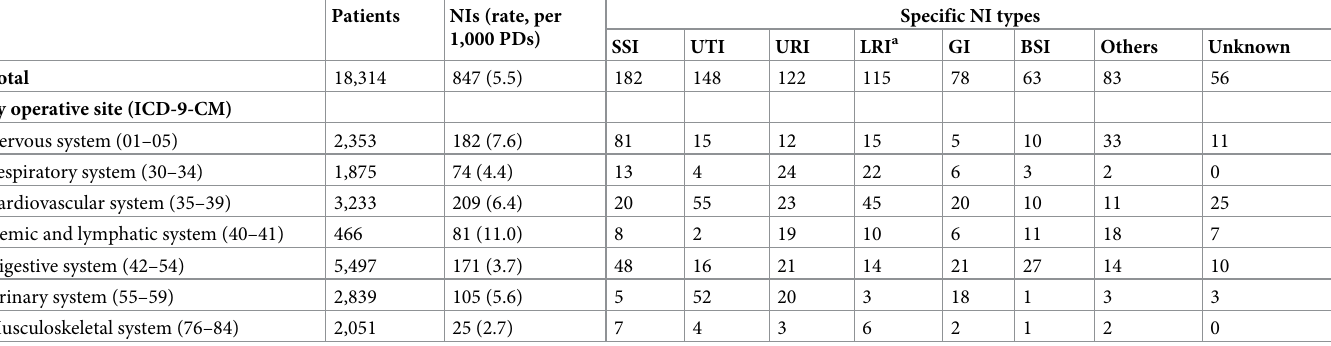
a Including ventilator-associated pneumonia. BSI bloodstream infection. ICD-9-CM (International Classification of Diseases, 9 th Revision, Clinical Modification), GI (gastrointestinal infection), LRI (lower respiratory tract infection), NI (nosocomial infection), PD (patient-day), SSI (surgical site infection), URI (upper respiratory tract infection), UTI (urinary tract infection).